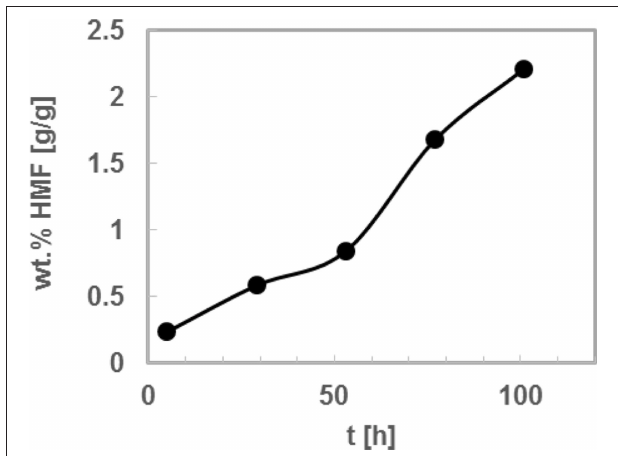
FIGURE 6 | 5-Hydroxymethylfurfural (HMF) weight fraction over time in the deep eutectic systems consisting of tetraethyl ammonium chloride and levulinic acid (TEAC:LA 1:2) with HPA-5 catalyst. Four wt% of the catalyst was added at t = 0 to the fructose + DES mixture undissolved as a powder. Reaction temperature: 323K; w FRU,0 = 2.5 wt.%. Symbols present data upon addition of 2.5 wt% fructose after each reaction